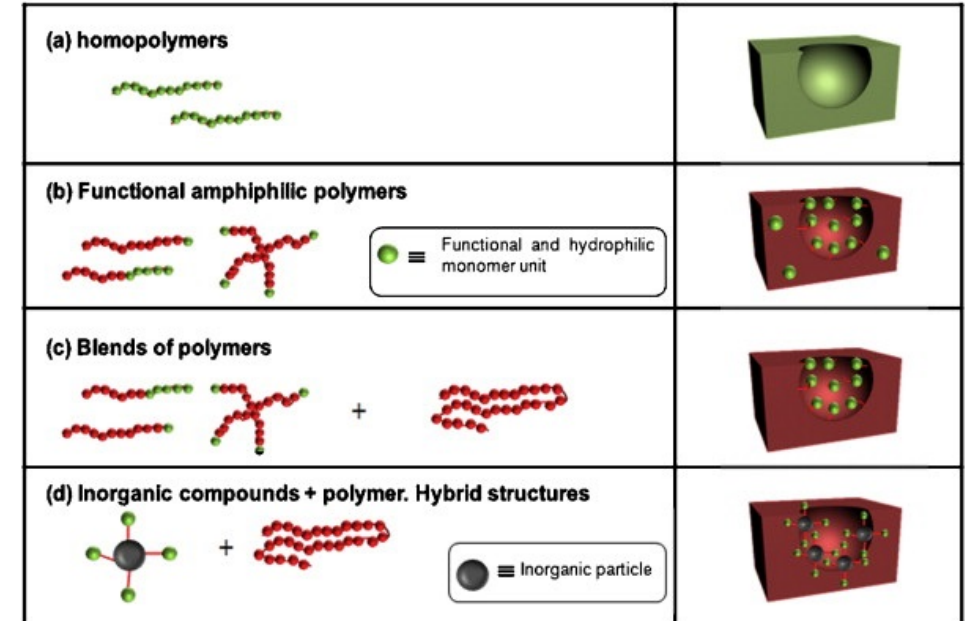
Figure 4. Various alternatives leading to functional surfaces being obtained in situ [2].